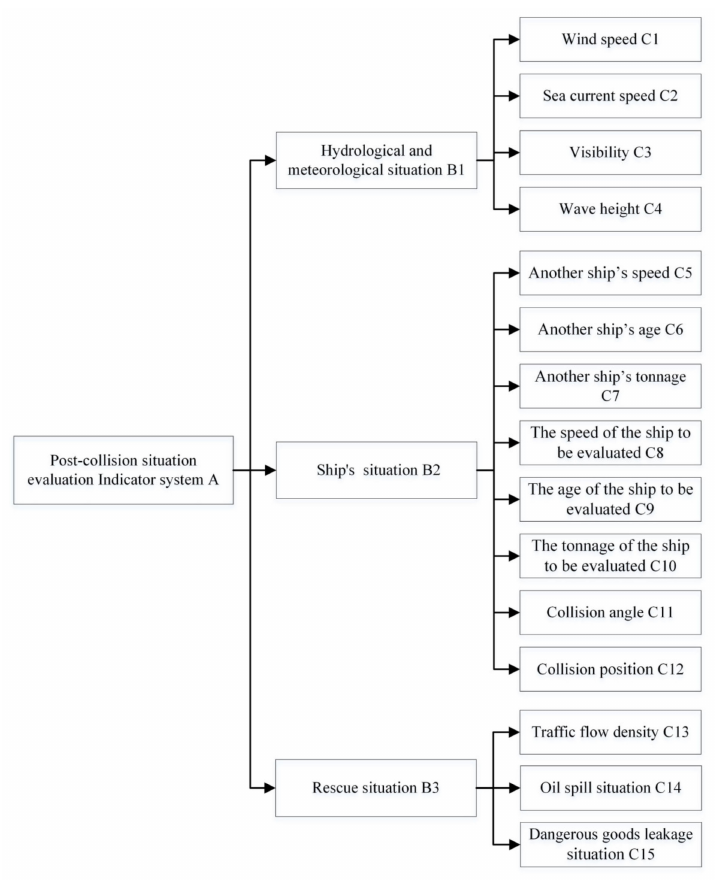
Figure 3. Indicator system for the emergency situation after